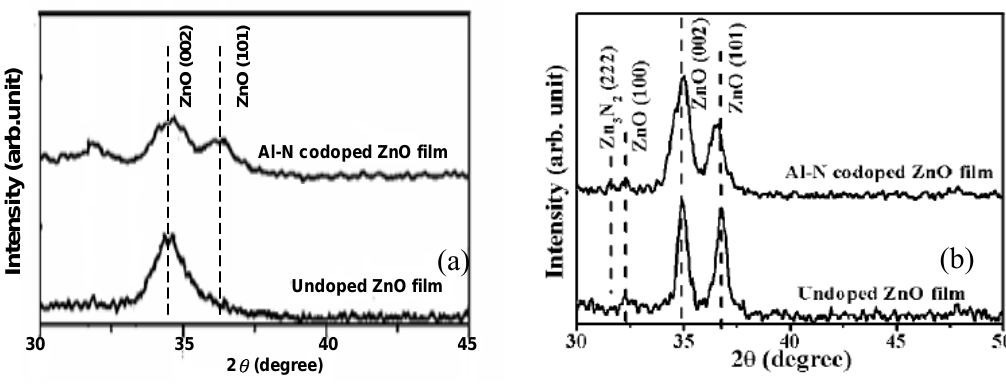
Figure 4. XPD patterns of undoped ZnO film and AlN codoped ZnO film (theoretical Al atomic ratio of 10%). (a) as-deposited (b) post-annealed at 400 °C under nitrogen ambient for 30 min. Reprinted from Ref. [20] with permission.